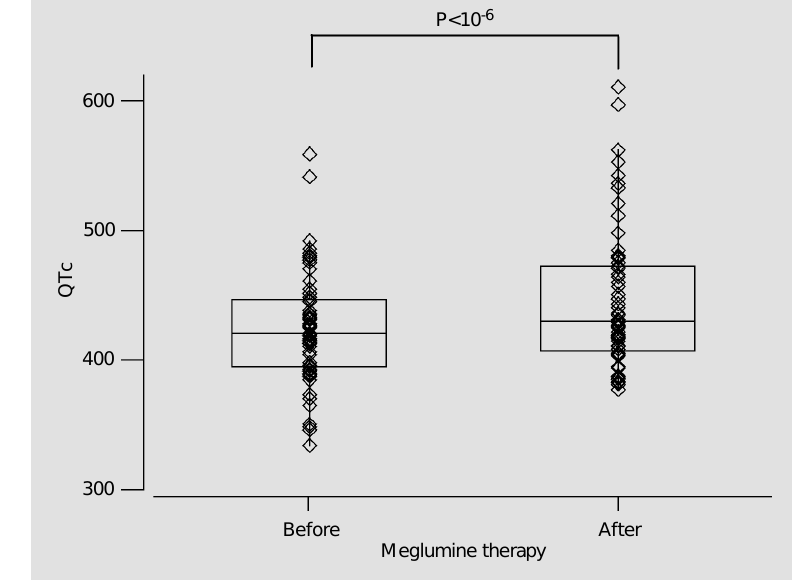
Figure 1 - Corrected QT interval (in milliseconds) before and after the first 10-day cycle of meglumine therapy in 62 cutaneous leishmaniasis patients. The Wilcoxon statistical test was